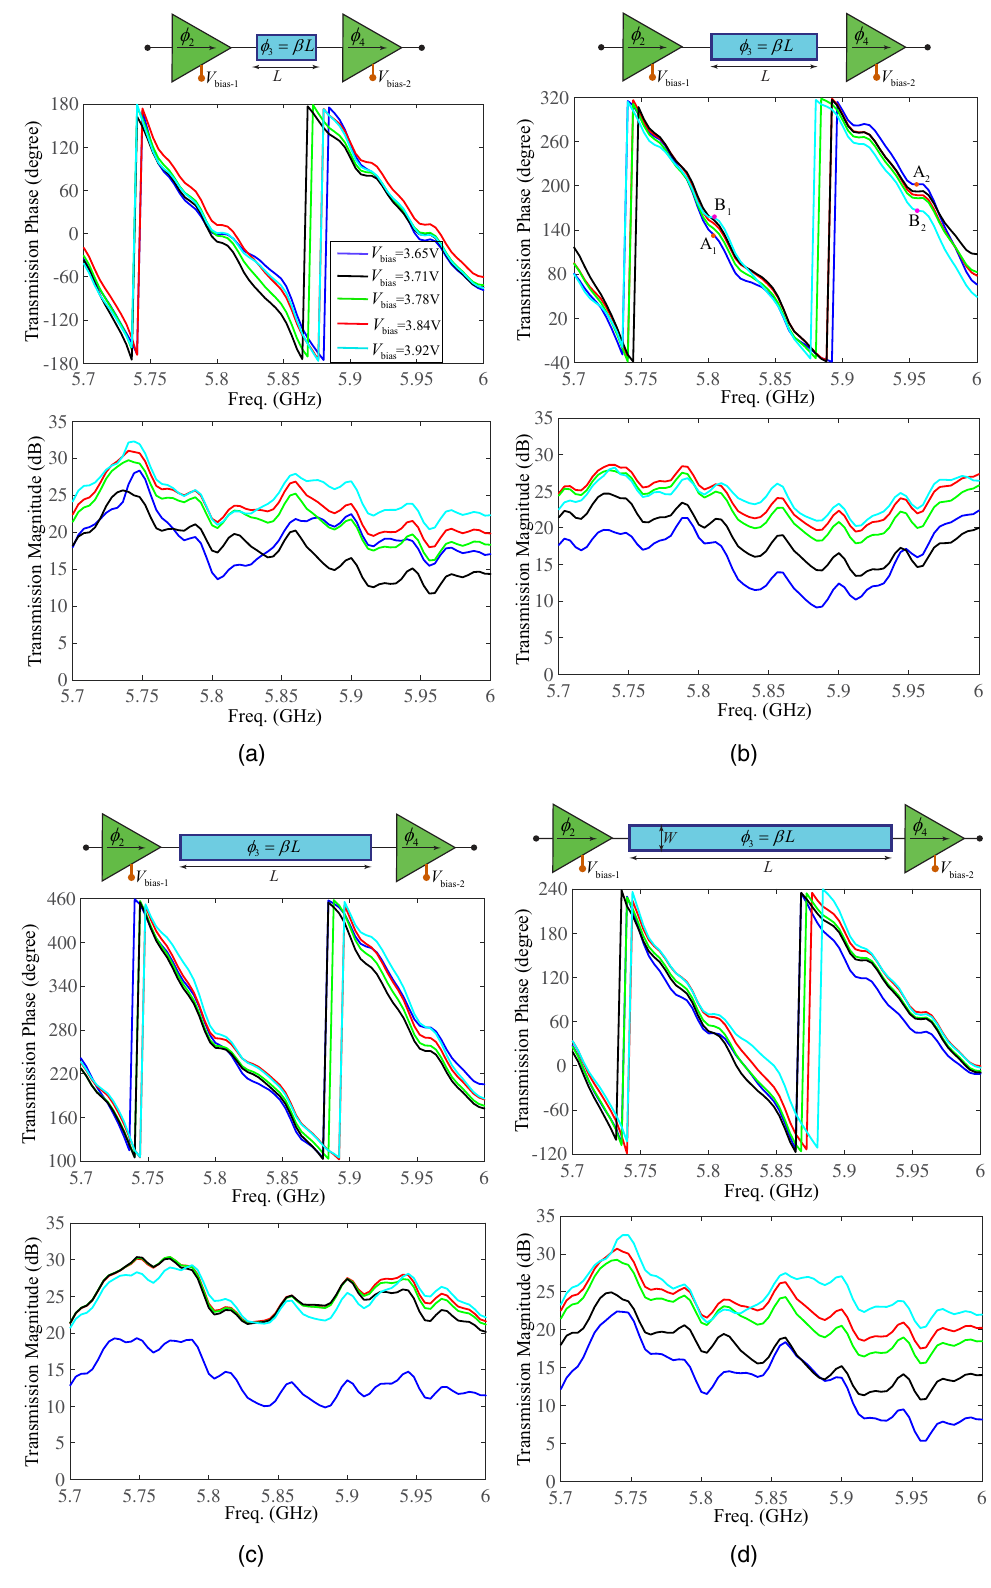
Figure 6. Experimental results for controlling the transmission phase shift (and magnitude) of the super-cell via unilateral amplifiers and central phase shifters for V bias-1 = V bias-2 = V bias . ( a ) L = 203 mils. ( b ) L = 475 mils. ( c ) L = 679 mils. ( d ) L = 950